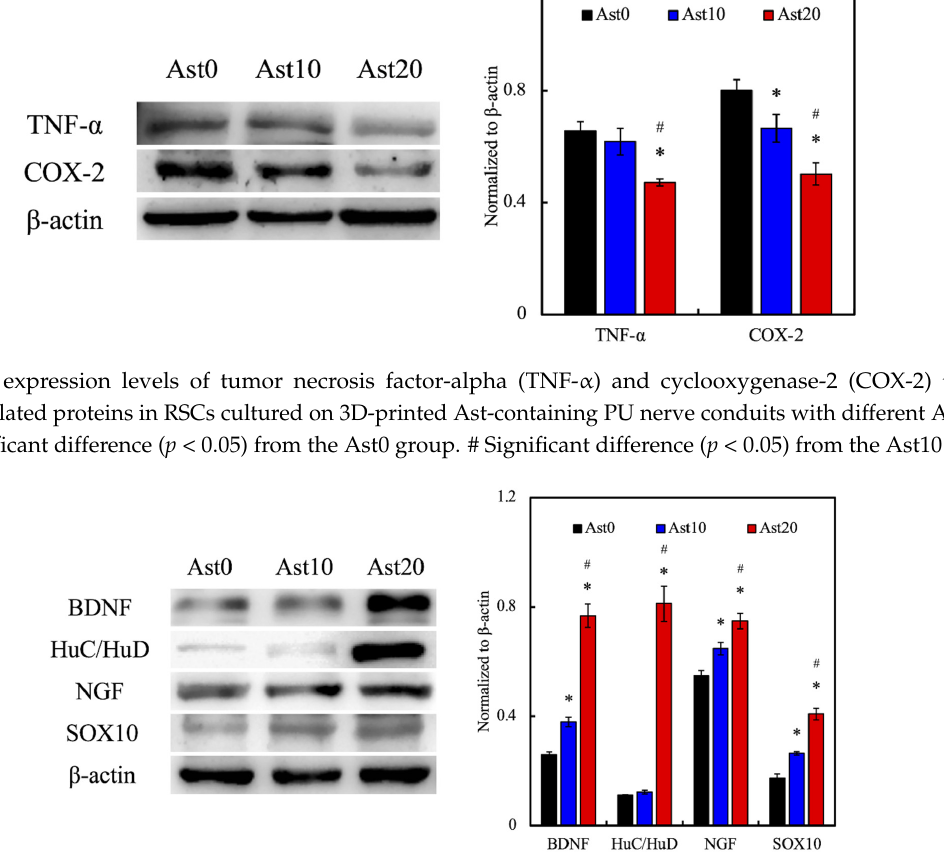
Figure 8. Western blot and quantification results of neural-regeneration-related proteins in RSCs cultured on 3D-printed Ast-containing PU nerve conduits with different Ast concentrations. * Significant difference ( p < 0.05) from the Ast0 group. # Significant difference ( p < 0.05) from the Ast10 group.